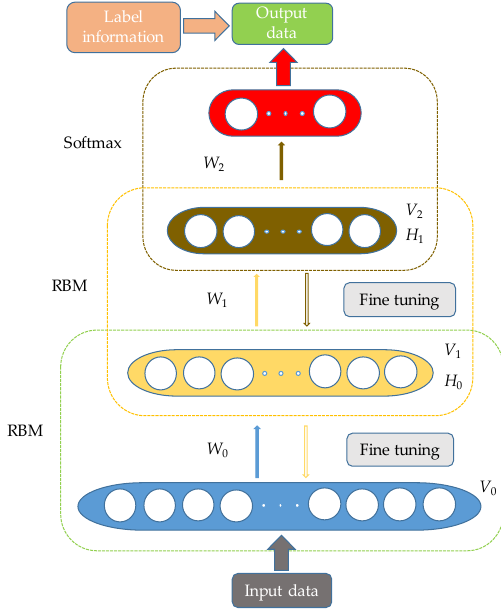
Figure 2. Deep belief network (DBN) model with double-layer restricted Boltzmann machine (RBM). The process of DBN training model can be mainly divided into two